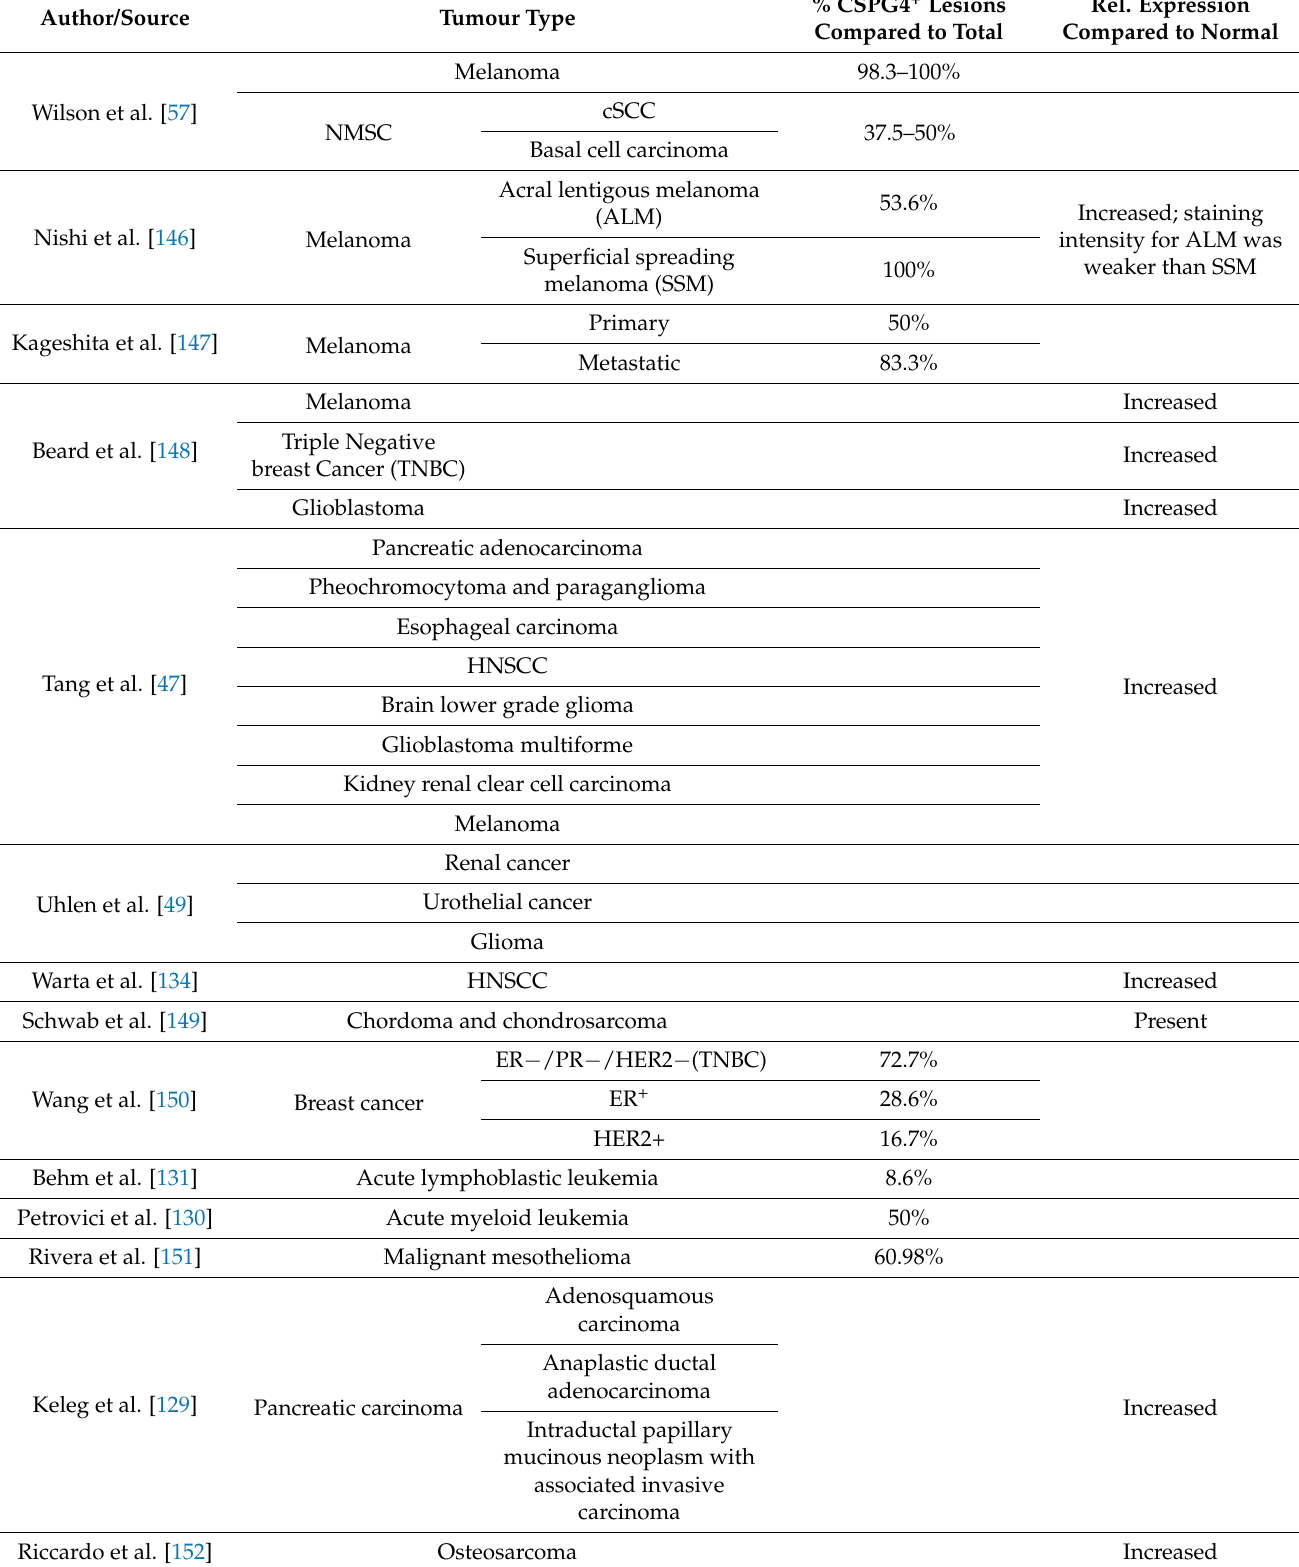
Table 2. CSPG4 expression in